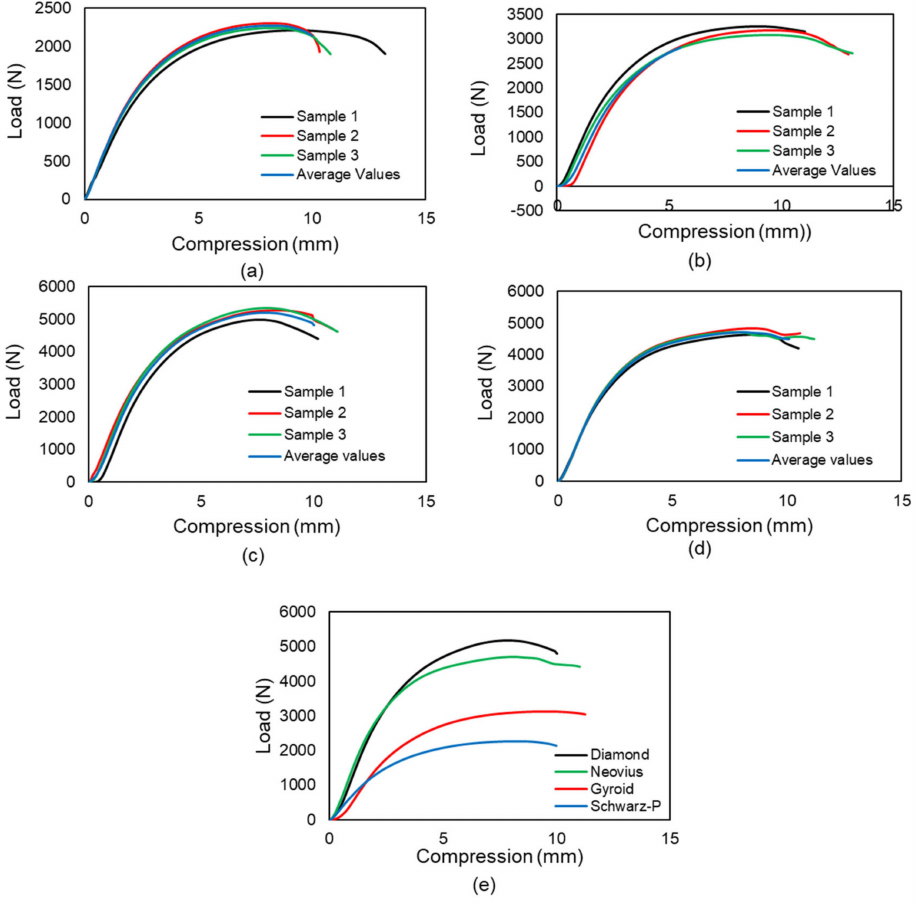
Figure 7. Load-compression graphs. The graphs a, b, c and d indicate that the three specimens of each sample exhibit the same behavior in the compression test, which suggests that printing performance is satisfactory. Average values are taken for future calculations: ( a ) Schwarz-P samples, ( b ) Gyroid samples, ( c ) Diamond samples and ( d ) Neovius samples. ( e ) Four sample average values comparison. The Diamond design exhibits the maximum buckling resistance, whereas Schwarz-P design displays the least resistance to